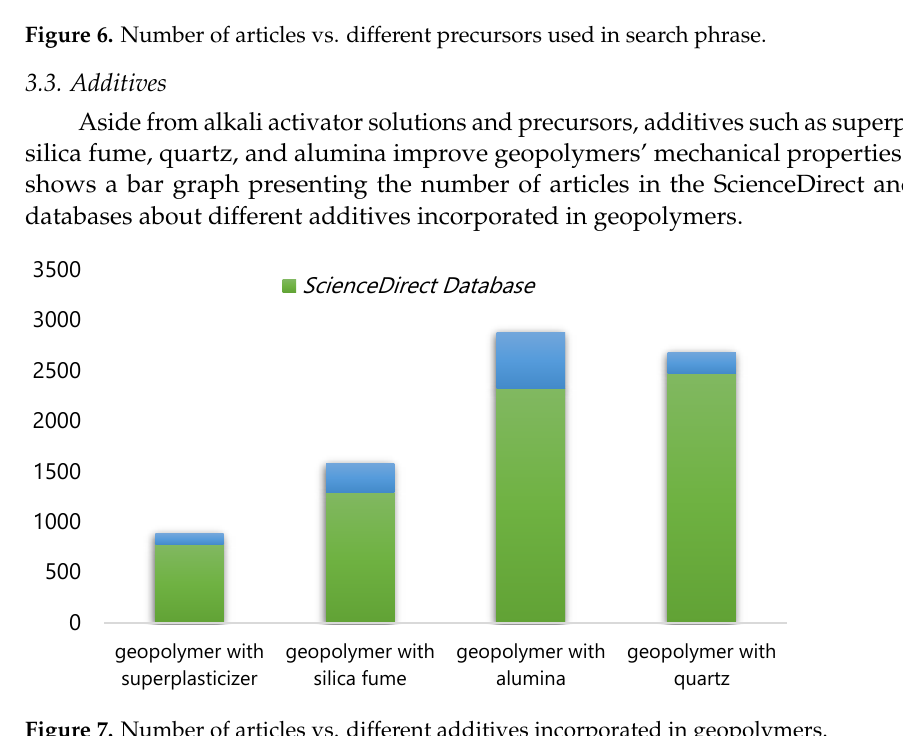
Figure 7. Number of articles vs. different additives incorporated in geopolymers.